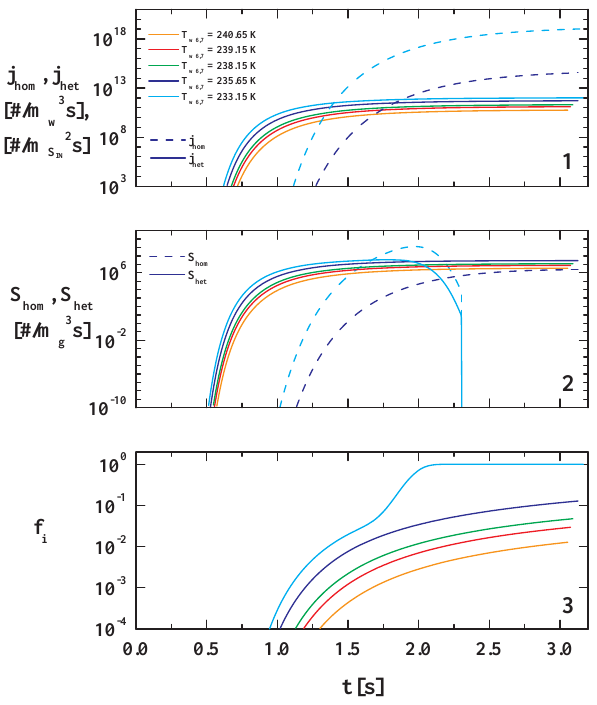
Fig. 5. Ice nucleation parameters for the freezing of supercooled water droplets as function of time along the centerline of LACIS for Fig. 15. Ice nucleation parameters for the freezing of supercooled different wall temperature settings (panel 1: homogeneous (dashed water droplets as function of time along the centerline of LACIS for lines) and heterogeneous (solid lines) ice nucleation rate coefficient, different wall temperature settings (panel 1: homogeneous (dashed panel 2: source term for homogeneous and heterogeneous ice mode, lines) and heterogeneous (solid lines) ice nucleation rate coefficient, panel 3: resulting ice panel 2: source term for homogeneous and heterogeneous ice mode, panel 3: resulting ice fraction).